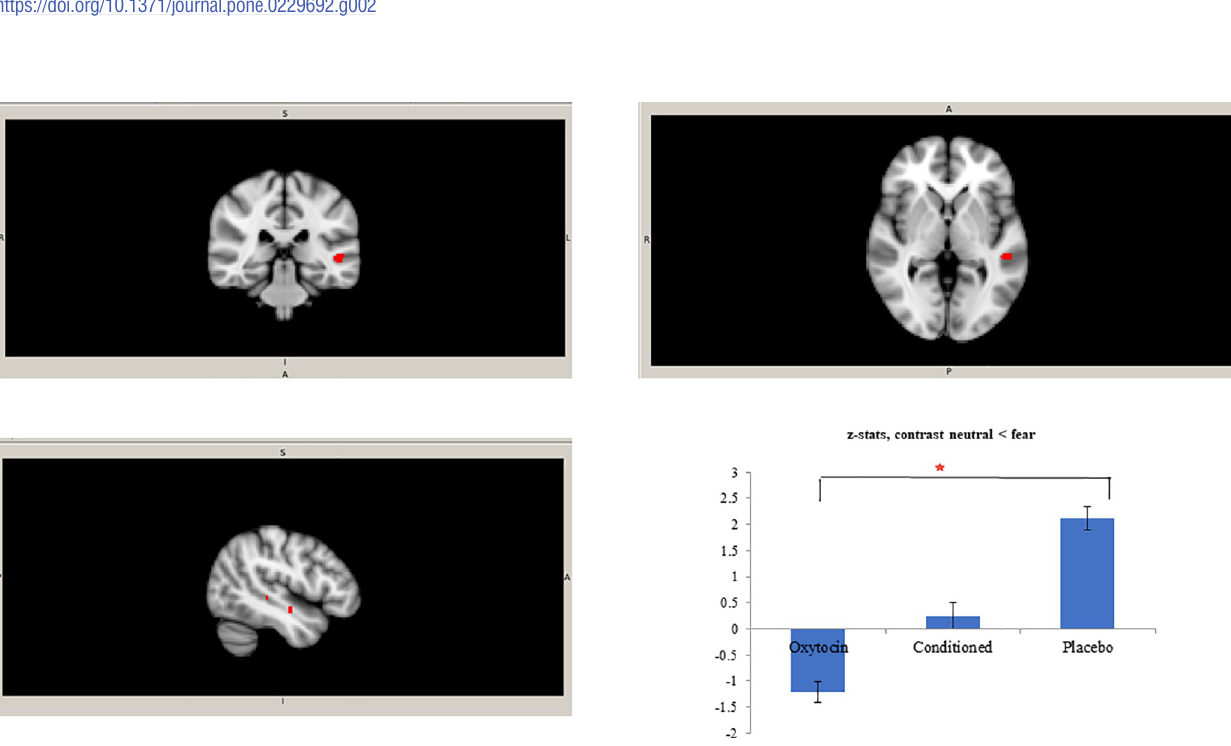
PLOS ONE | https://doi.org/10.1371/journal.pone.0229692 March 19,